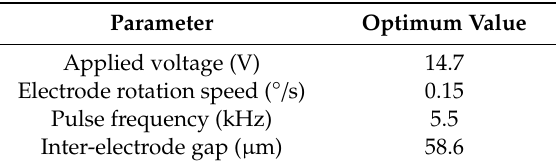
Figure 6. Optimal machining parameters with ( a ) maximum MRA and ( b ) minimum R a . Table 6. Optimum value of parameters.